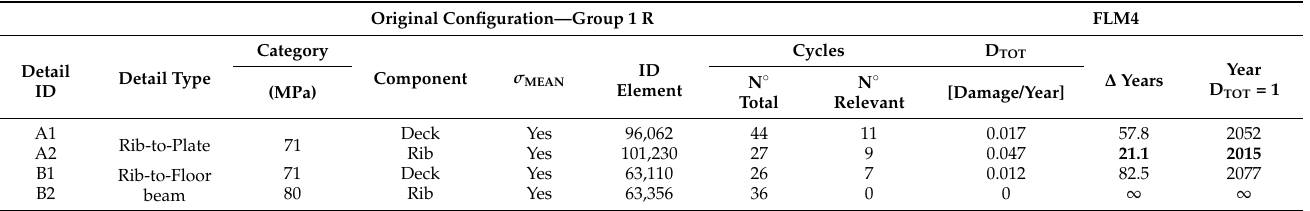
Table 10. Results of damage checks in the original configuration—Group 1 (R). Original Configuration—Group 1 R